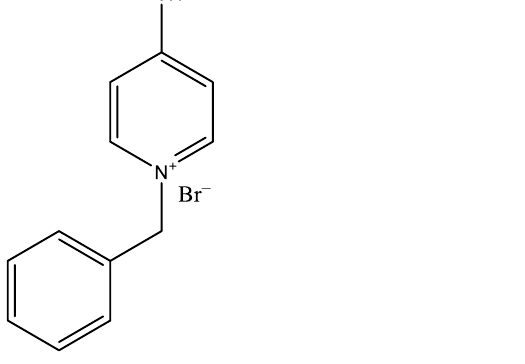
Figure 8. Structure of the 1-benzyl-4- N,N -dimethylaminopyridinium salt. Adapted from [30].